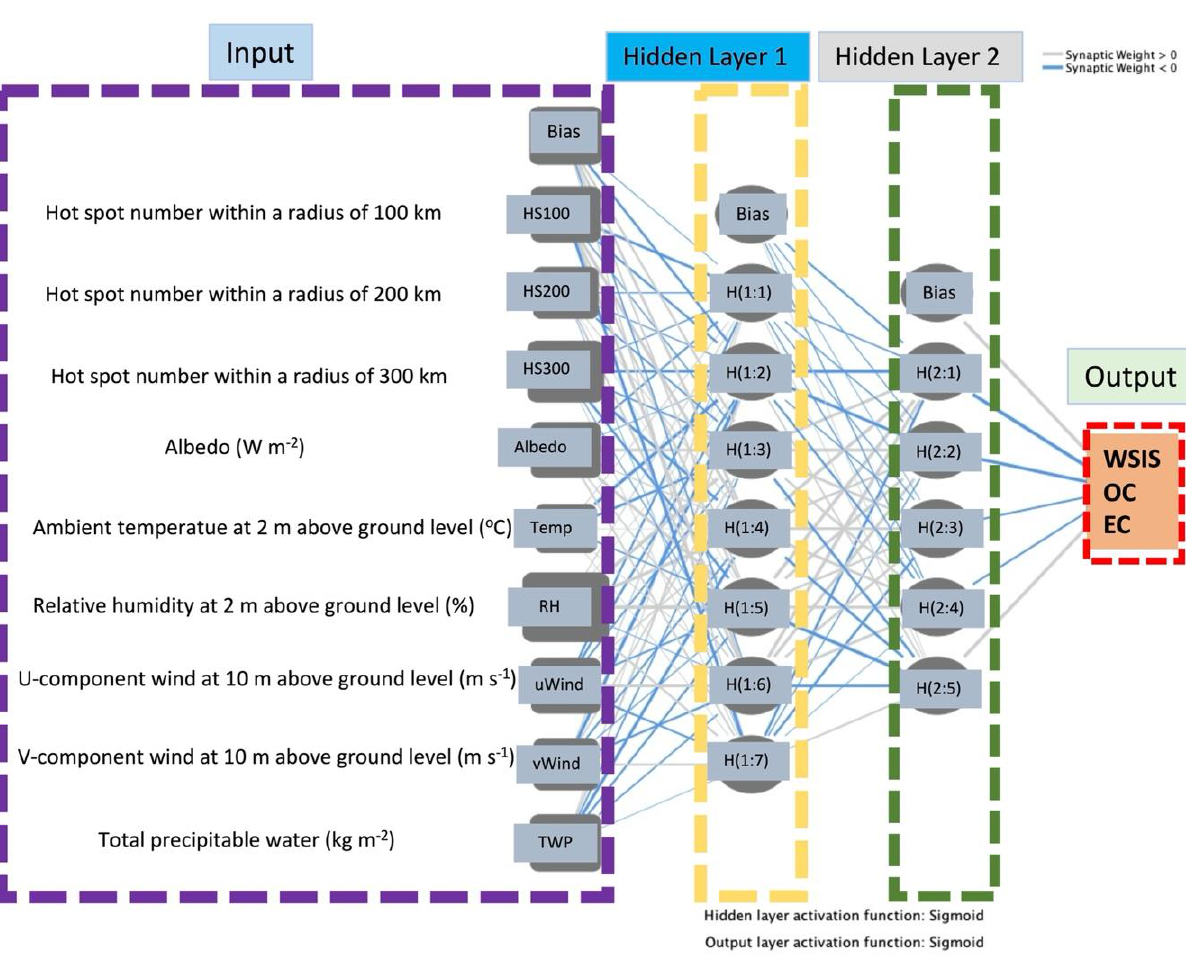
Figure 2. Feed forward neural network for PM 2.5 -bounded WSIS, OC , and EC predictions.